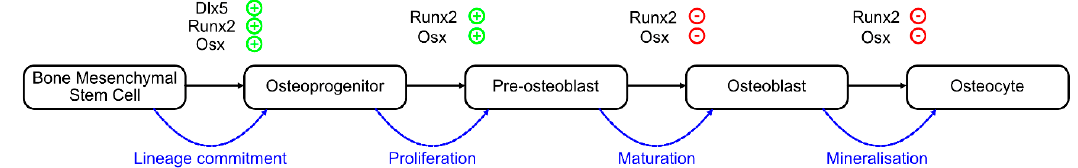
Figure 1. Differentiation pathway of the osteoblast lineage. Lineage commitment occurs through mesenchymal stem cell (MSC) to osteoprogenitor transition. Proliferation is the next stage, during which the pre-osteoblast is formed. The maturation of the pre-osteoblast is followed by the mineralization of the matrix, in which the fully matured osteocyte embeds. Dlx5, Runx2 and Osterix (Osx) are key transcription factors which play the roles of both activators and inhibitors (+ or − ) during different stages of differentiation and maturation.